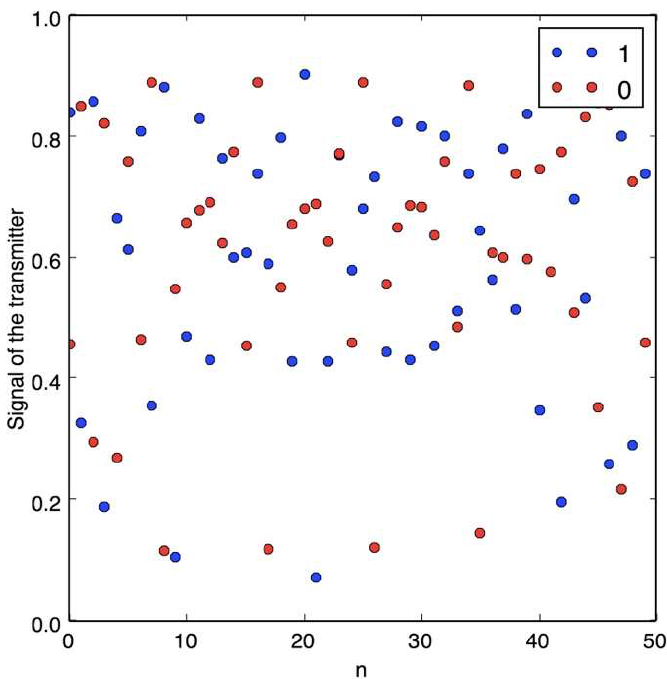
Figure 5. An example of the data, which can be captured from the communication channel by an unauthorized receiver.